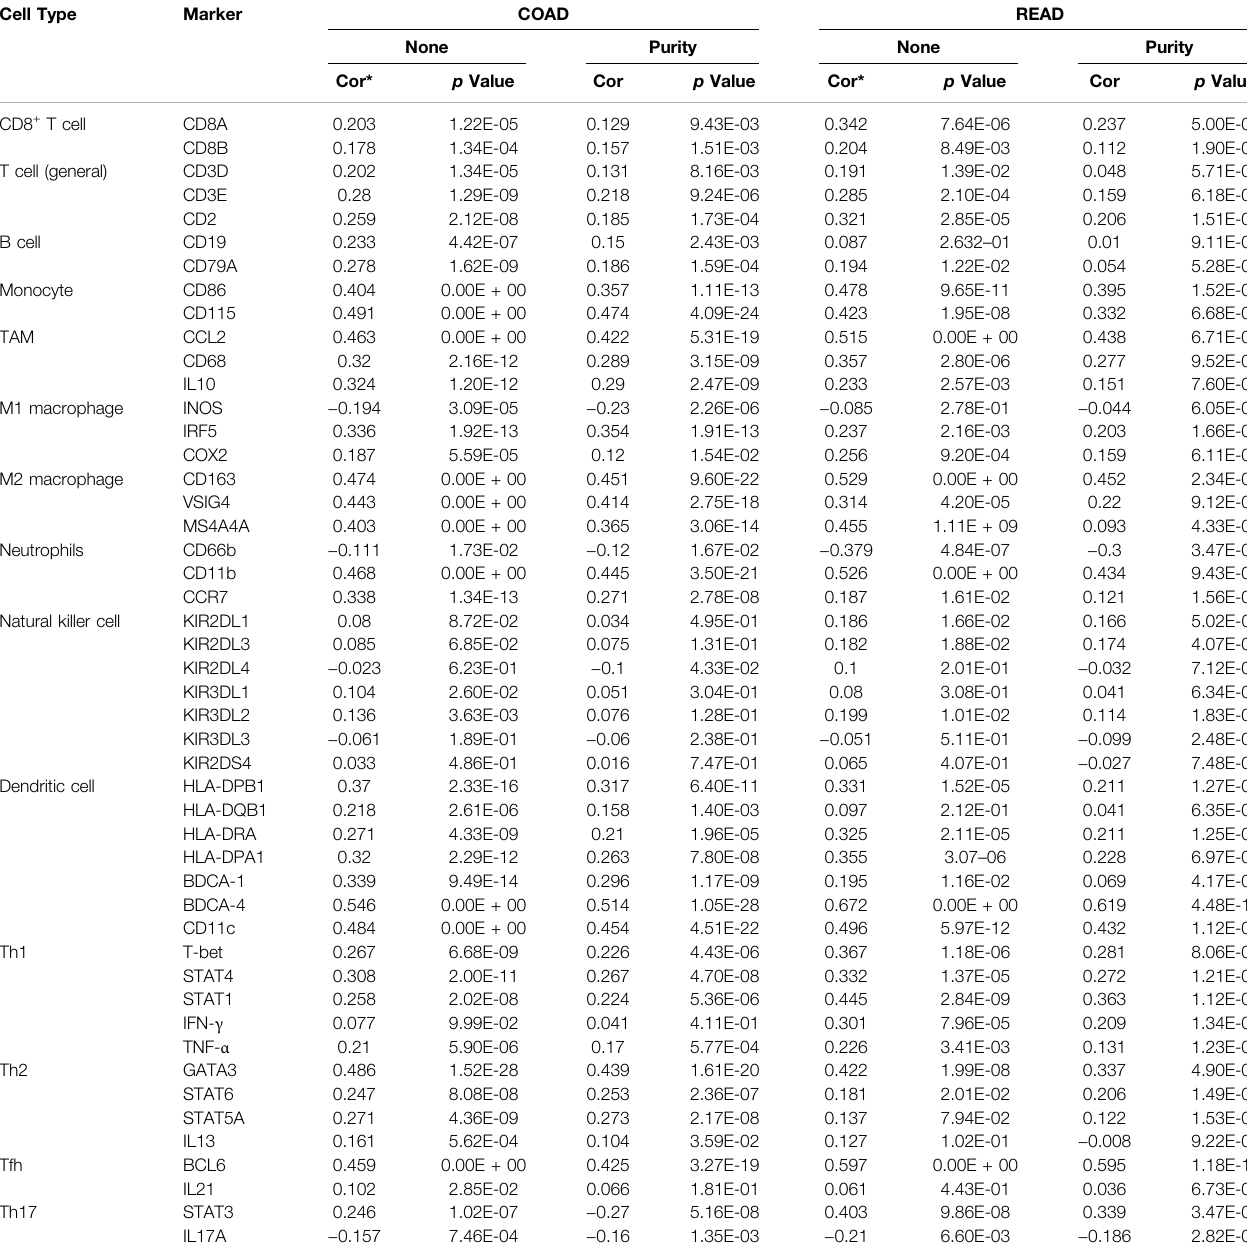
TABLE 1 | Correlation analysis between RIMKLB and related gene markers of immune cells in COAD and READ. Cell Type Marker COAD READ None Purity None